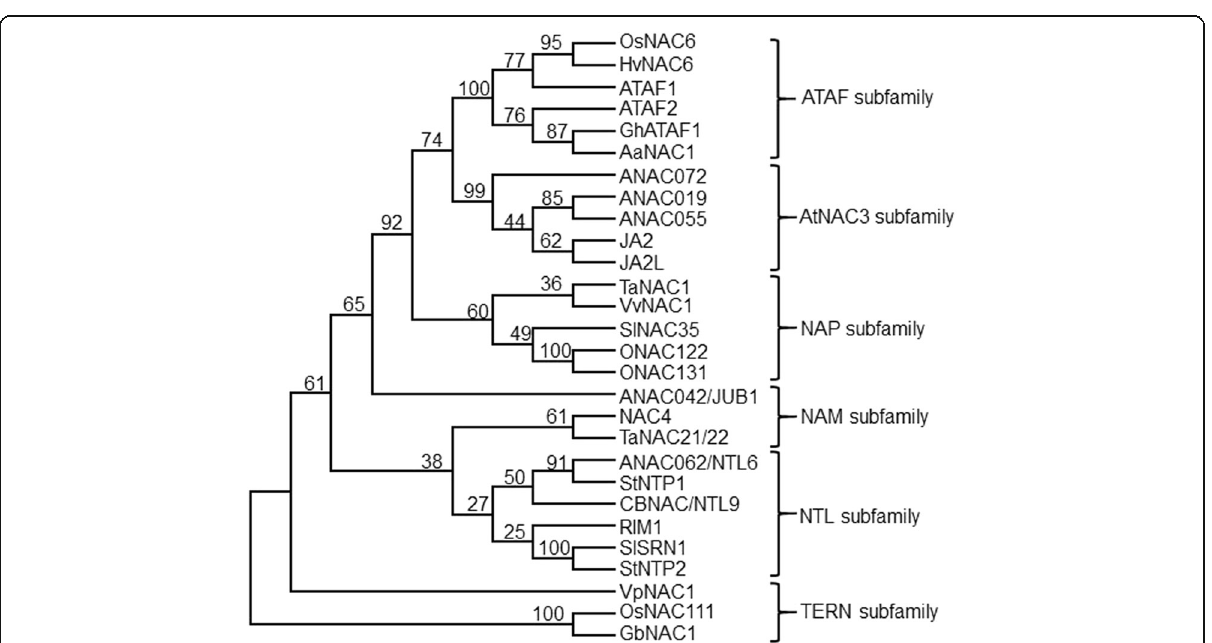
Fig. 1 Phylogenetic tree of the reported immunity-related NAC TFs. The tree was constructed using the Neighbour-Joining algorithm method and bootstrap values from 1000 replicates are indicated at each node. The GenBank accession numbers are as follows: OsNAC6, BAA89800; HvNAC6, AM500854; ATAF1, NP_171677.1; ATAF2, NP_680161; GhATAF1, DT549350.1; AaNAC1, AQU15092.1; ANAC072/RD26, NP_001078452.1; ANAC019, NP_175697; ANAC055, NP_188169.1; JA2, NP_001233972.1; JA2L, NP_001306107.1; TaNAC1, AEI00649.1; VvNAC1, XP_002282566; SlNAC35, XM_004236996; ONAC122, BAF27472.1; ONAC131, BAT15671.1; ANAC042/JUB1, NP_181828; NAC4, NP_568182.2; TaNAC21/22, AGV08300.1; ANAC062/NTL6, NP_190522.1; StNTP1, AGY49284.1; CBNAC/NTL9, NP_001119122.1; RIM1, BAS82017.1; SlSRN1,